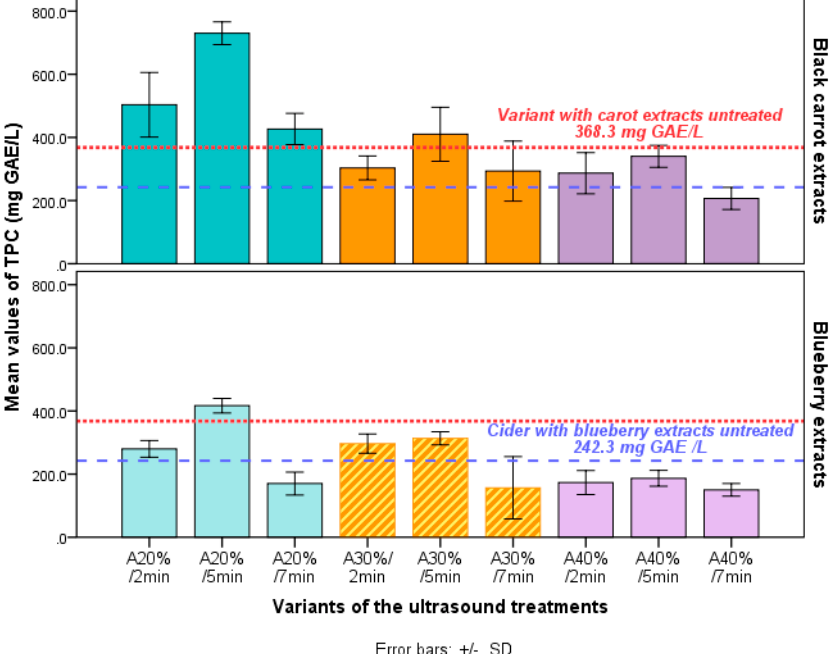
Figure 1. Effects of the ultrasound treatments and of extracts additions (for obtaining cider enriched with antioxidants) on the TPC values (mg GAE/L). Data are means of 3 experiments (n = 3). Abbreviations: TPC—total phenolic content; GAE—gallic acid equivalent; A—amplitude.